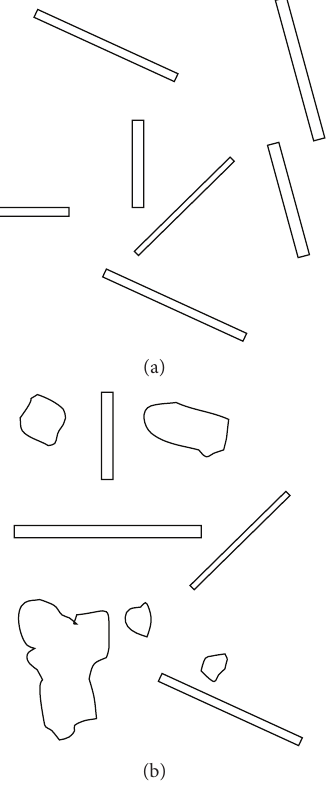
Figure 6: Morphologies of Ag 3 Sn compound at varying Ag concen- trations with (a) 1.0 Ag to 3.0 Ag alloying and (b) 4.0 Ag